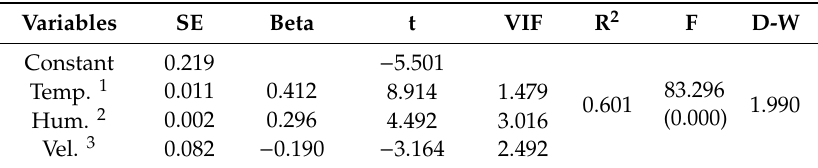
Table 3. Result of multiple regression analysis for Betula platyphylla